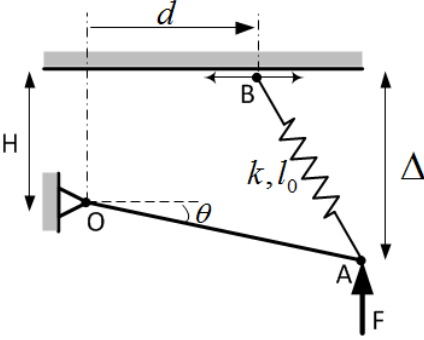
Figure 1. Variable Sti ff ness